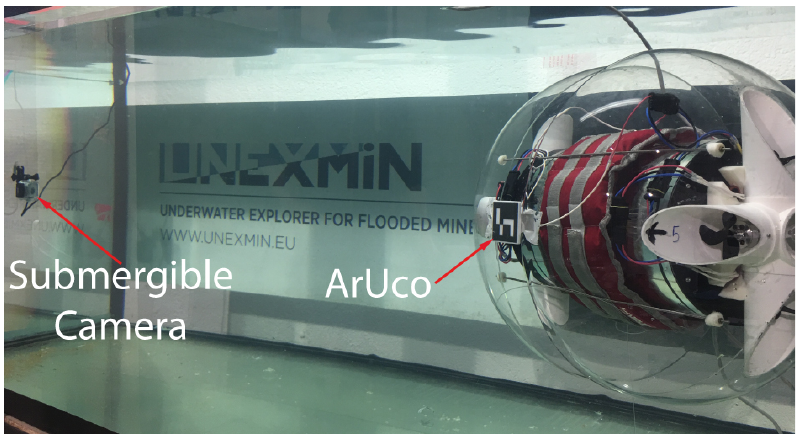
Figure 8. Underwater tests experimental setup. A submergible camera was installed inside the tank to estimate the position of the